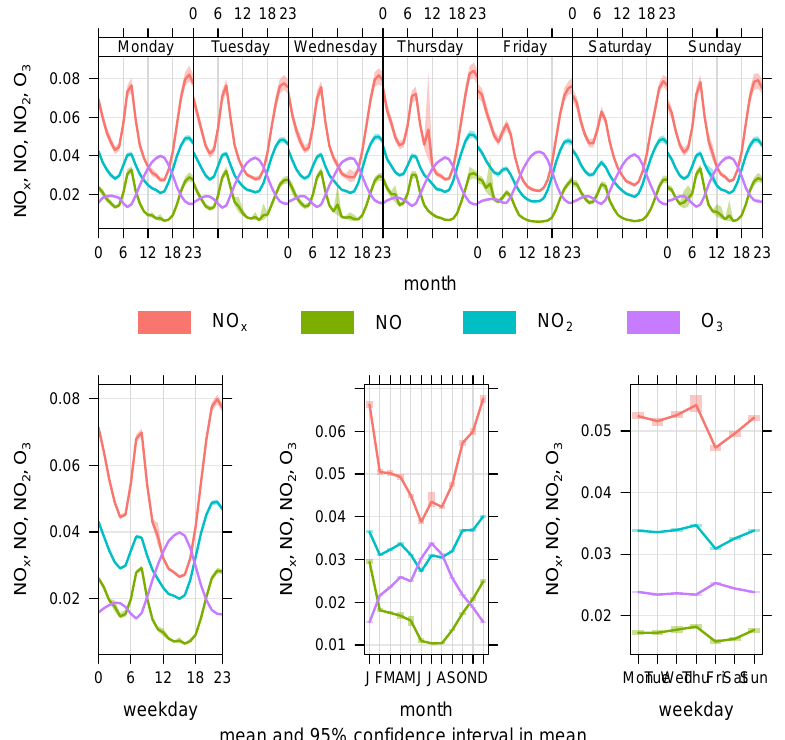
Figure 4. Temporal variation of the Studied Pollutants according to the station site from 2012 to 2017 for NO , NOx , NO 2 and O 3 —EPA Kuwait.